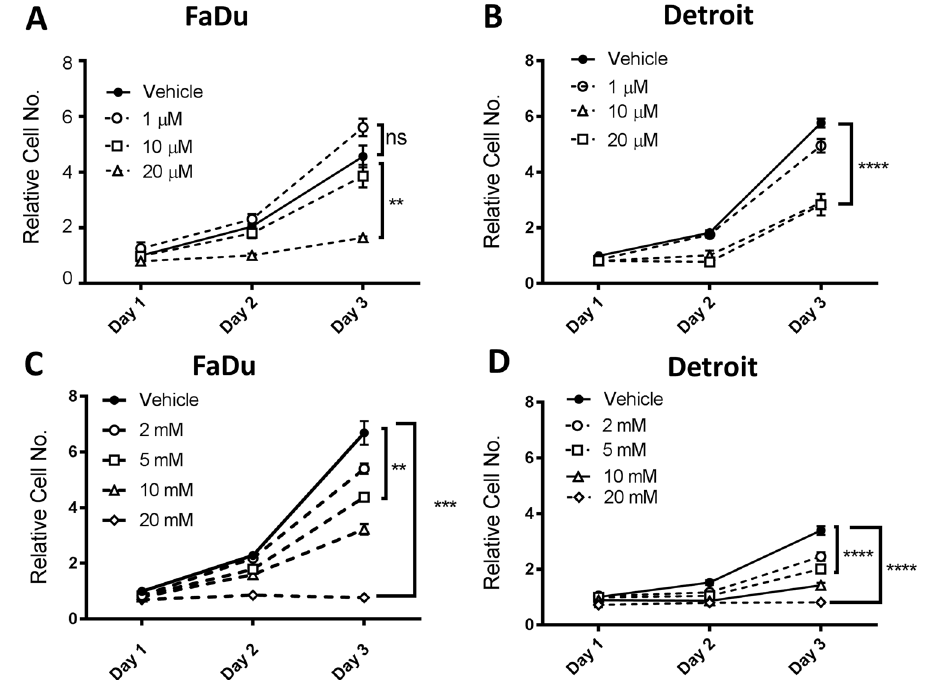
Figure 2. BPTES and metformin suppresses the growth of HNSCC. FaDu and Detroit 562 cell lines were used to assess the effects of BPTES and metformin at indicated concentrations. For both cell lines, 10,000 cells were seeded in a 96-well plate and treated with indicated concentrations of BPTES or metformin for 24 hours, 48 hours and 72 hours. The relative live cell numbers were indicated by the absorbance readings after crystal violet staining. ( A ) FaDu cells treated with Vehicle (DMSO) or BPTES; ( B ) FaDu cells treated with vehicle (PBS) or metformin; ( C ) Detroit 562 cells treated with Vehicle (DMSO) or BPTES; ( D ) Detroit 562 cells treated with vehicle (PBS) or metformin. ** p < 0.01, *** p < 0.001, **** p <